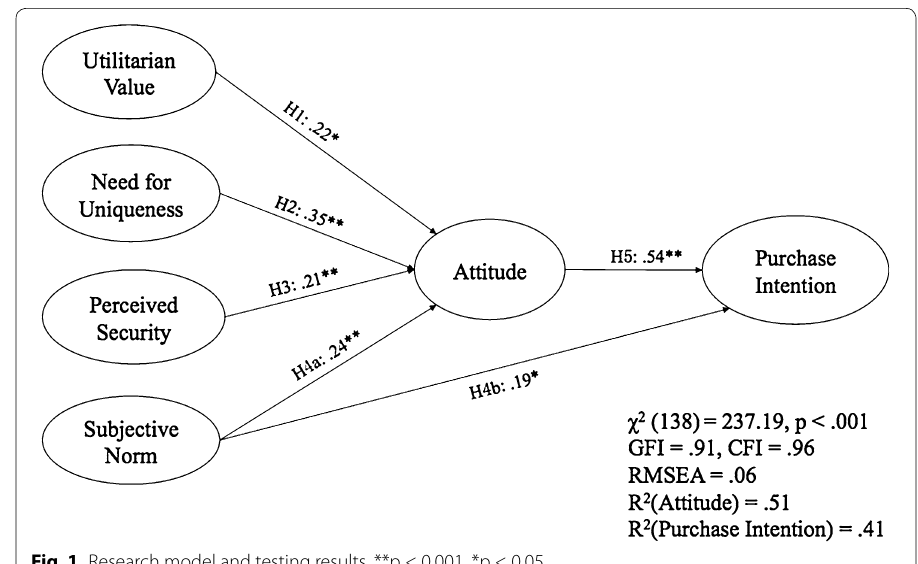
Fig. 1 Research model and testing results. **p < 0.001, *p <